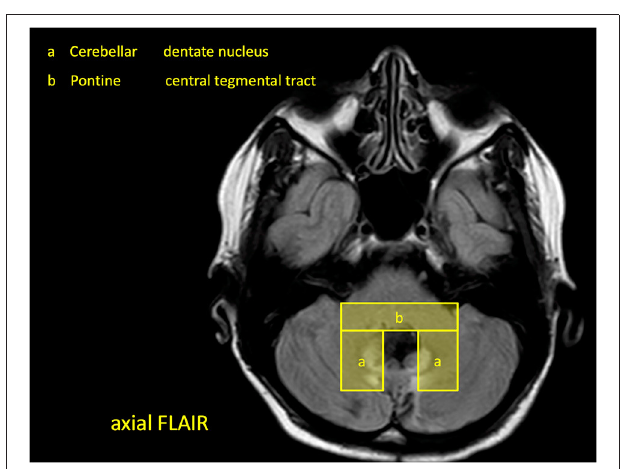
FIGURE 4 | Excerpt of the study brochure, which shows an MRI template with the regions of interest.